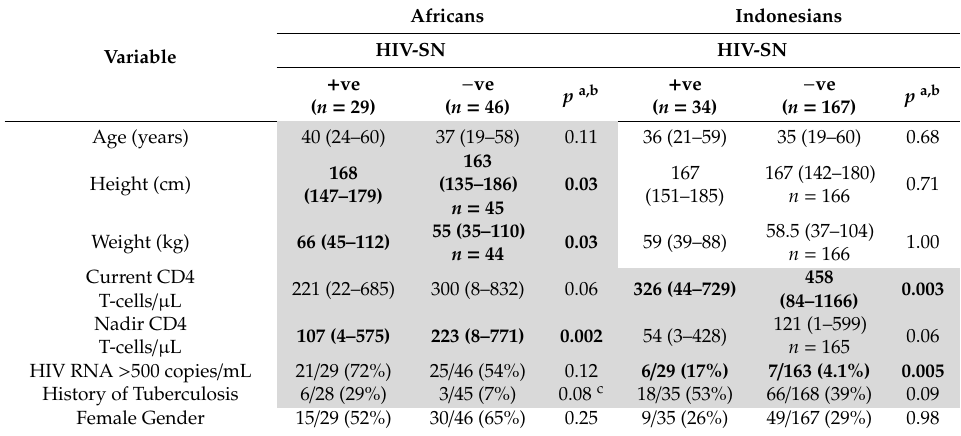
Table 1. HIV-SN associates with CD4 T-cell counts and control of HIV